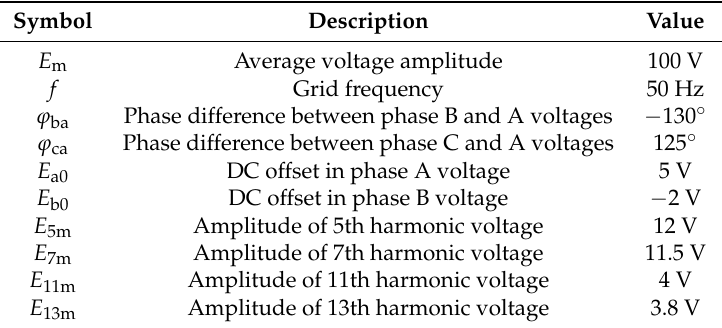
Table 1. Simulation